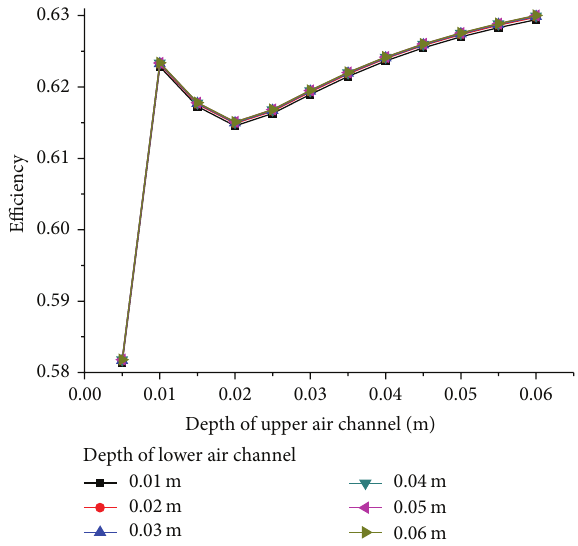
Figure 12: Effect of depths of air channels on efficiency of the collector in water heating mode (0.06 m thick insulation).